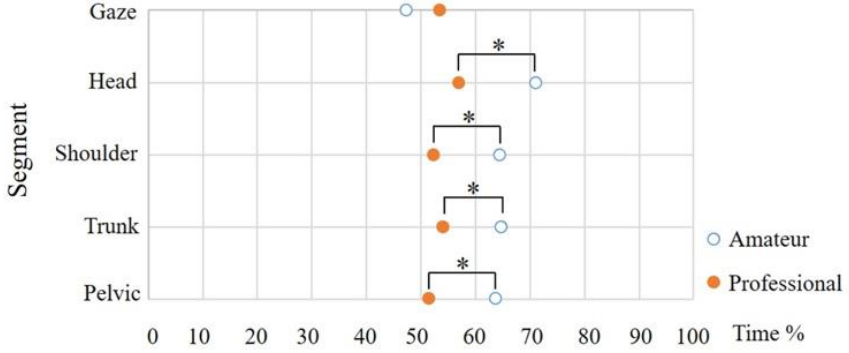
Figure 6. For the amateur group, there was a simple main effect of the segment. The timing of gaze was significantly earlier than the head, shoulder, trunk, and pelvis of the amateur group (*: p < 0.001). For the professional group, there was no significant single main effect.